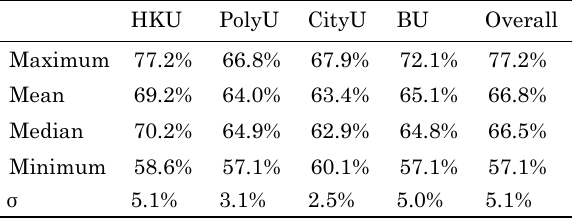
Table 6. Summary statistics of the VIIS assessment